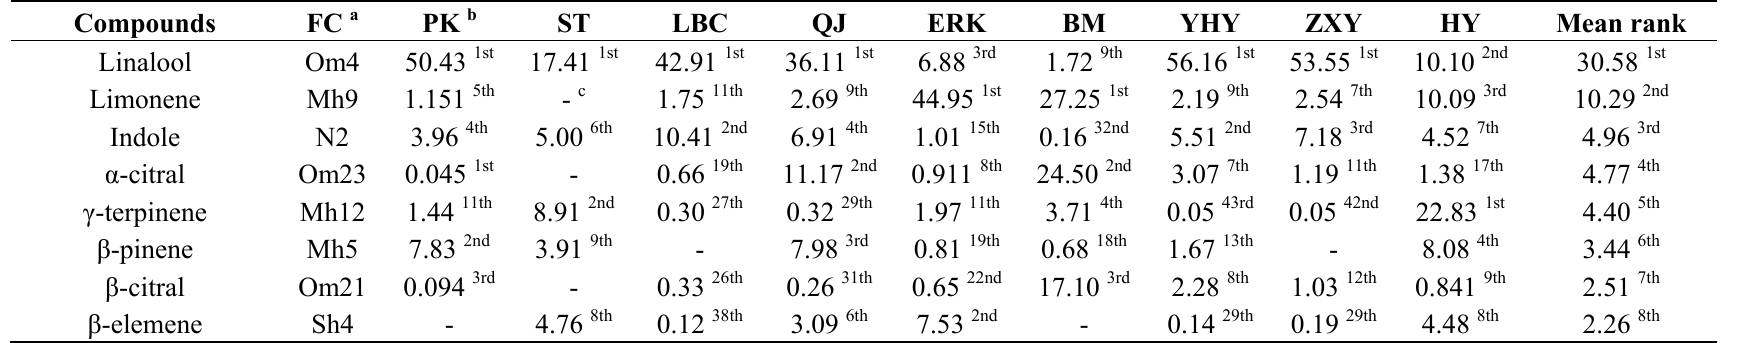
Table 4. Major volatiles compounds, in percentages and rank, from half opened flowers from nine citrus cultivars.